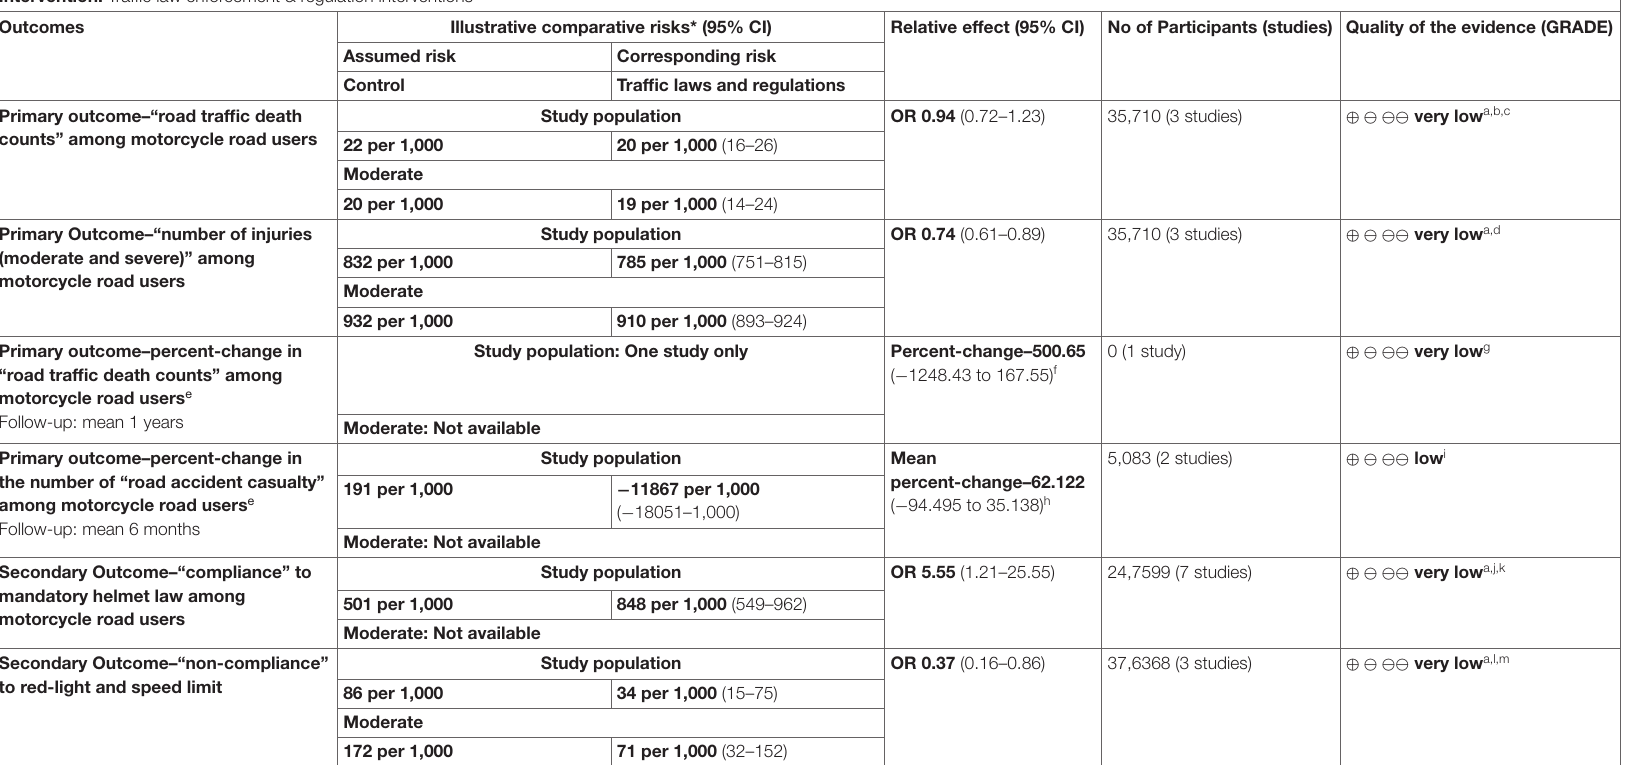
TABLE 5 | Summary of findings (GRADE) for traffic laws and regulation interventions. Patient or population: Vulnerable (non-motorized and motorized two-wheel) road users; Settings: Low- and middle-income